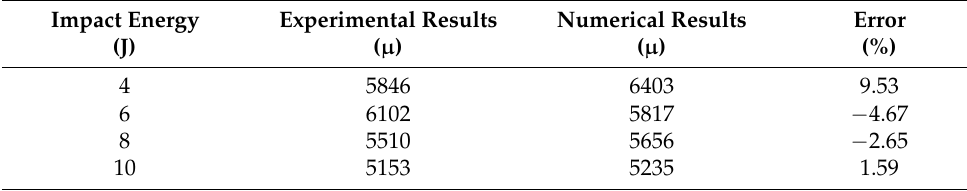
Table 7. Comparison of the residual